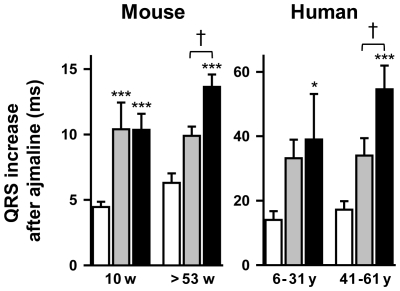
Variable effects of Na+ channel blockade in Scn5a
+/− mice and SCN5A-mutated patients.Ajmaline-induced increase in QRS interval (Y-axes) in 10 week- and >53 week-old WT (n = 11 and n = 10; open bars), mildly (n = 10 and n = 10; grey bars) and severely (n = 11 and n = 10; black bars) affected Scn5a
+/− mice (left panel), and in young (6–31 years; mean = 22 years) and older (41–61 years; mean = 50 years) non-mutated (n = 18 and n = 17, open bars) and SCN5A-mutated patients with either mild (n = 12 and n = 11; grey filled bars) or severe (n = 7 and n = 12; black filled bars) QRS interval prolongation (right panel). *, ***, p<0.05 and p<0.001 respectively versus WT mice or non-mutated patients. †, p<0.05 versus Scn5a
+/− mice or SCN5A-mutated patients with a mild phenotype. The difference between old mildly affected mice and old WT mice did not reach significance (p = 0.07). Same comment for the older patients.